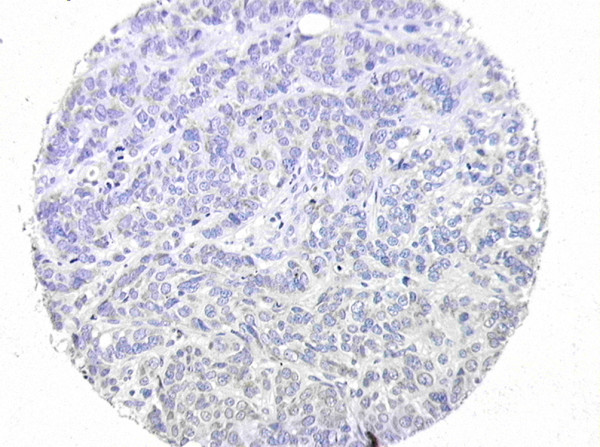
Tissue microarray core demonstrating tumour with absent Lewisy/b expression. Fifty-six percent of breast tumours were entirely negative for Lewisy/b expression using SC101 monoclonal antibody.